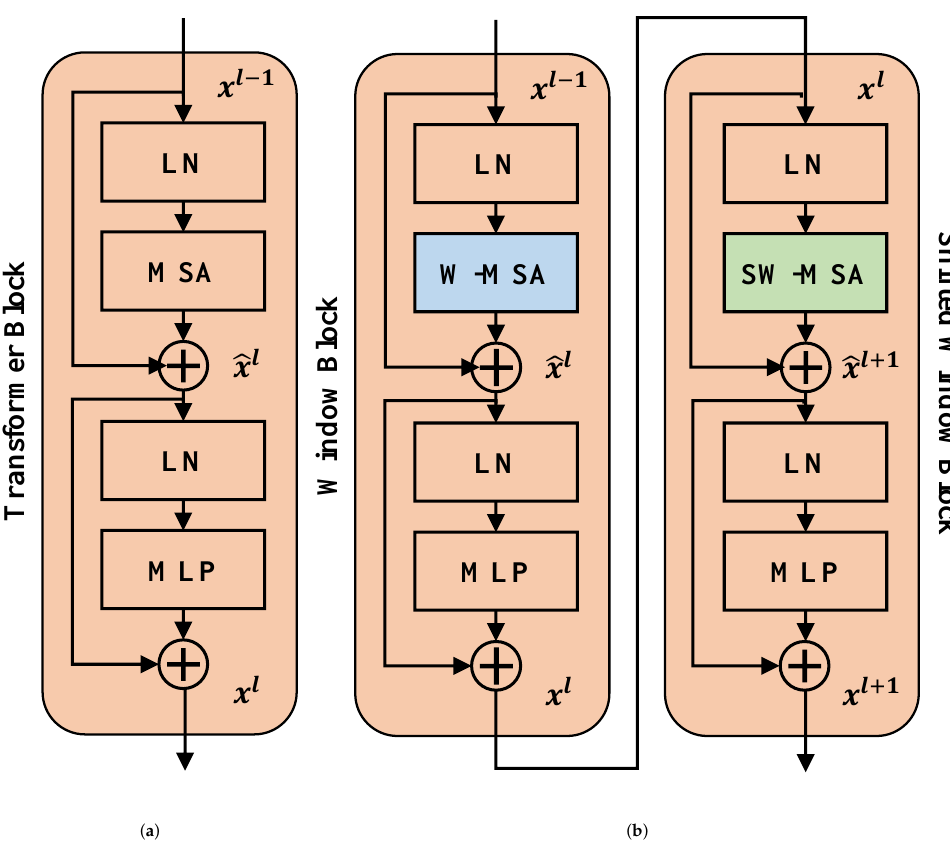
Figure 3. Illustration of different transformer blocks. ( a ) The standard transformer block. ( b ) Two successive Swin transformer blocks, the window block and shifted window block, which compute window multi-head self-attention (W-MSA) and shifted window multi-head self-attention (SW-MSA), respectively. LN and MLP denote layer normalization and multi-layer perceptron,